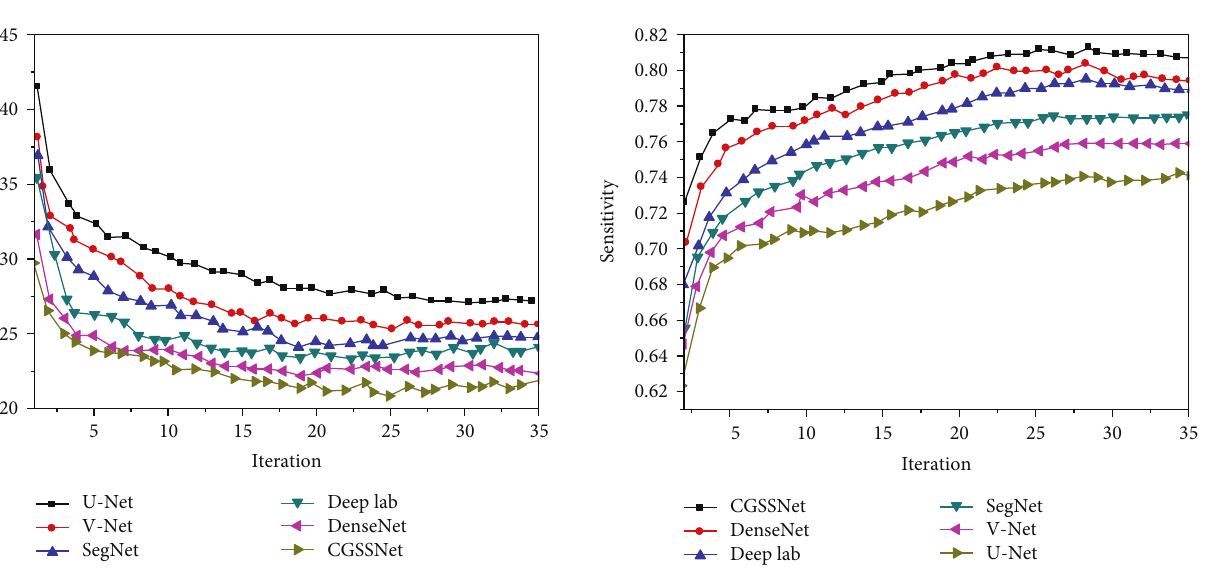
Figure 10: Comparison for sensitivity of various